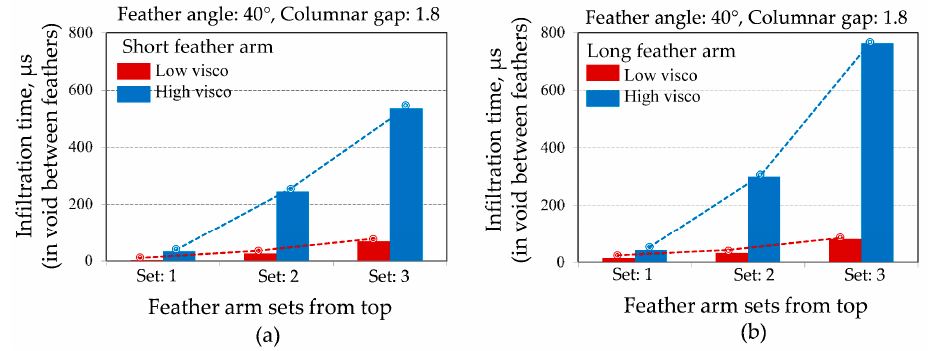
Figure 19. Comparison of CMAS infiltration into the feather gaps for different feather sets using a low and a high viscosity parameter simulated in a model with 40° feather inclination and 1.8 µm columnar gap: ( a ) comparison of infiltration time to fill up three short feather gaps; and ( b ) comparison of infiltration time to fill up three long feather gaps.